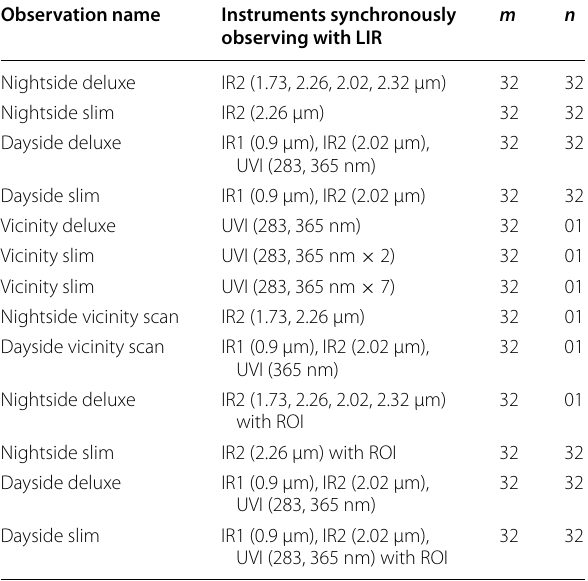
An additional observation with m 2016 ROI region of interest: a specific area selected from an images of IR1, IR2, and UVI in order to limit data